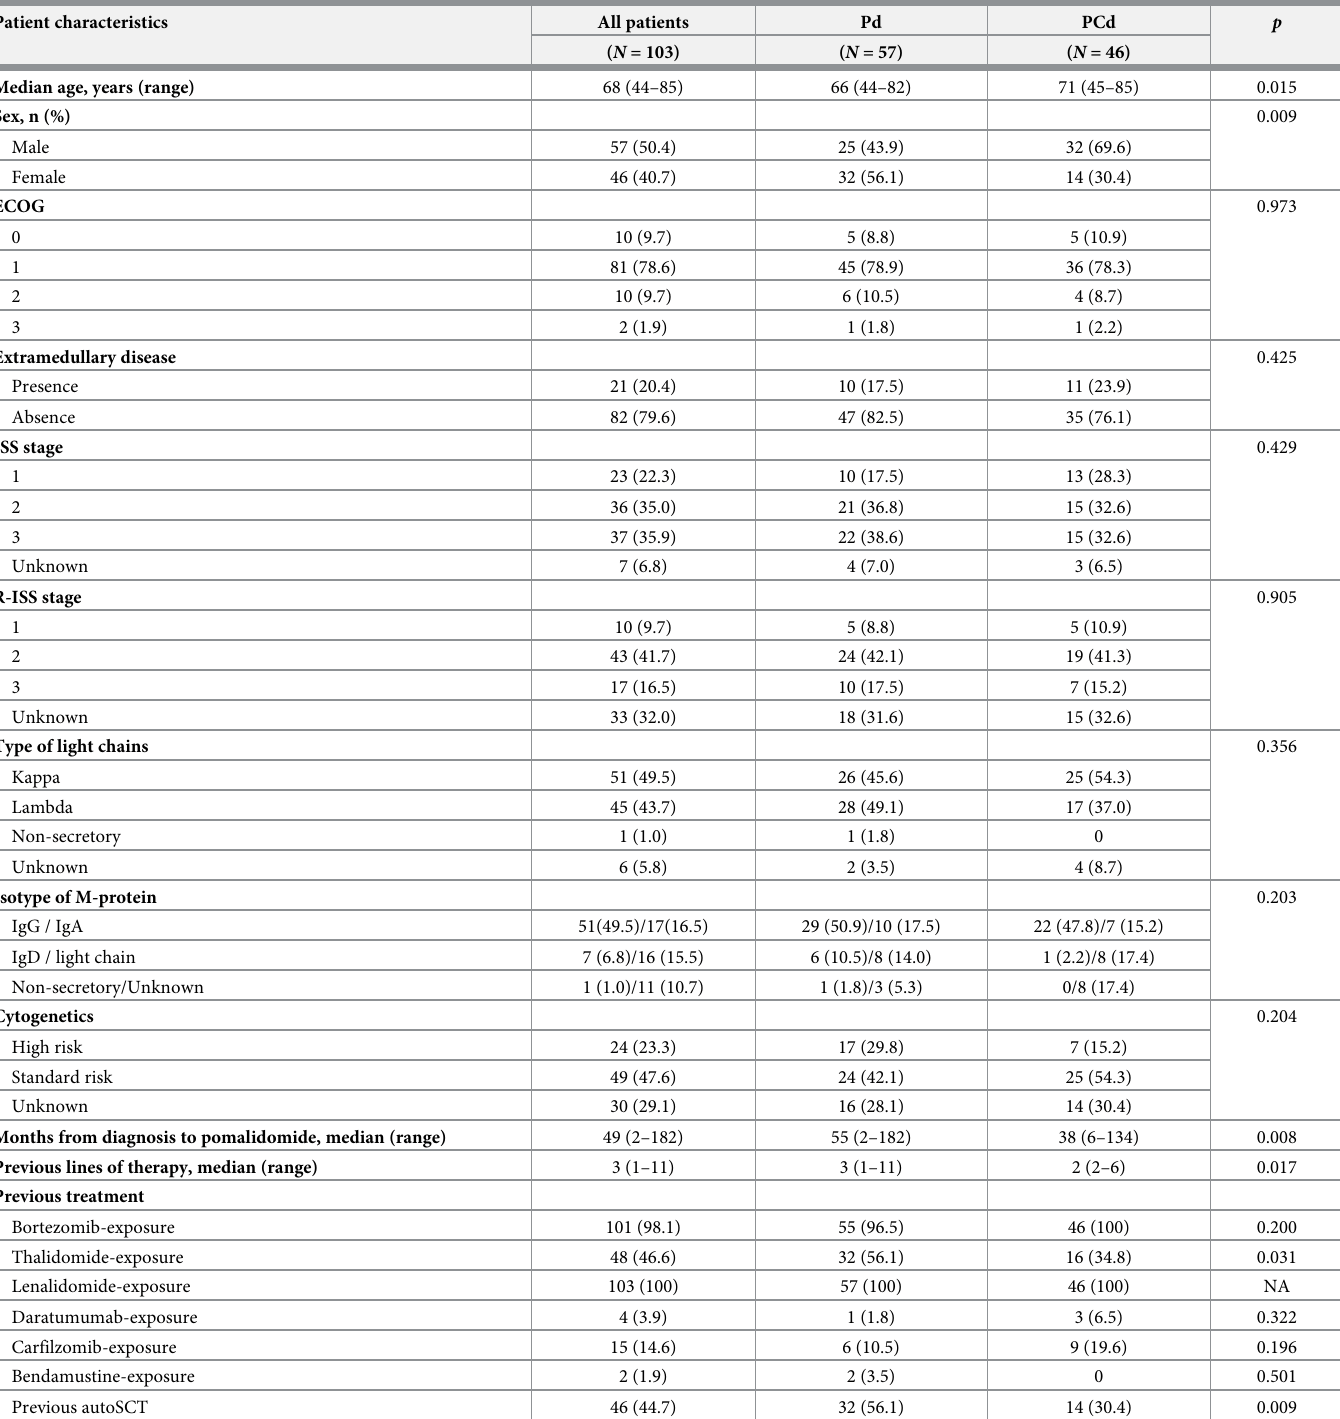
Table 1. Baseline characteristics of